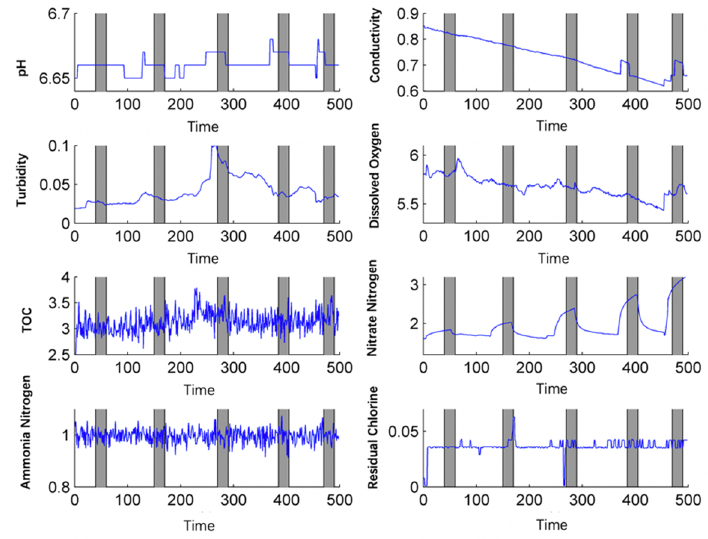
Figure 6. Response curve of water quality indicators for Ammonium Citrate.